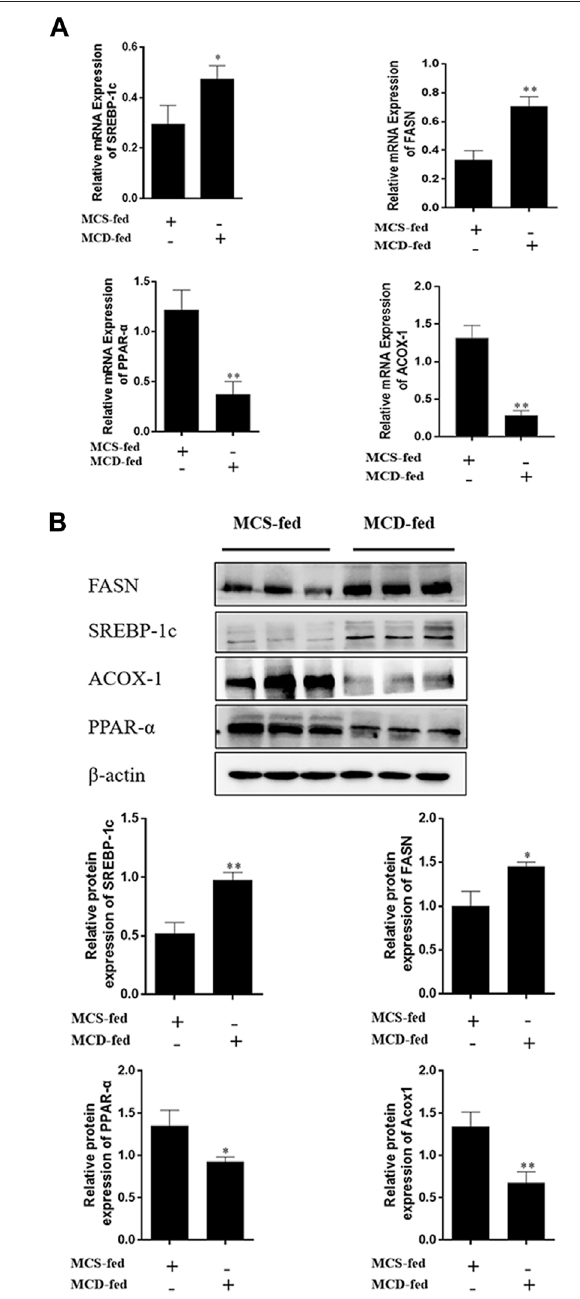
FIGURE 2 | Expression level of lipid metabolism cytokine in MCD-fed mice. (A,B) ThemRNAandprotein expressionlevelsofFASNandSERBP-1C were increased. PPAR- α and ACOX-1 expression were decreased in NAFLD livertissues.(Dataarerepresentedbyatleastthree independent mean ± SD, * p < 0.05, ** p < 0.01 vs normal group). To analyze the regulation mechanism of TMEM88 on lipid synthesis and metabolism cytokines, AML-12 cells were